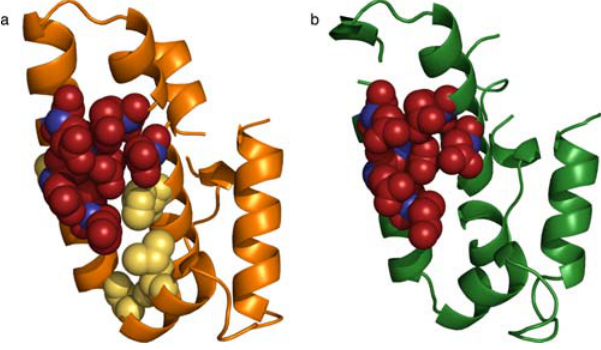
Figure 2. Example of Evolutionary Trace Annotation. Illustration of a source protein (2a, PDB 1yvw, chain A), its ET cluster (yellow), residues chosen as a template from that cluster (red), and the C a atoms which define the geometry of the template (blue); and its functionally relevant match in a target protein (2b, PDB 2a7w, chain A), with corresponding match residues (red) and C a atoms (blue).